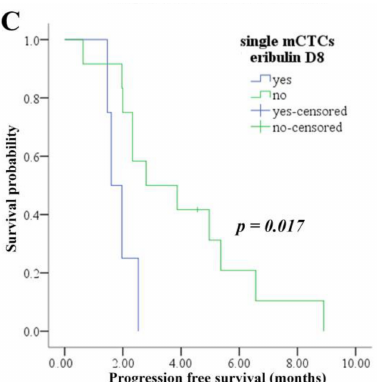
Figure 3. Detection and clinical significance of eCTCs / mCTCs subpopulations on D8 of the first eribulin cycle. ( A ) Percentages of eCTCs and mCTCs in total, single and cluster CTCs on days 1 (before eribulin) and 8 after the first administration of eribulin. Decrease in % of mCTCs in total CTCs ( p = 0.047) and in cluster CTCs ( p = 0.0001), are shown. Chi square test; statistical significance at the * p ≤ 0.05 and *** p ≤ 0.001. ( B , C ) Kaplan-Meier analysis of progression-free survival (PFS) according to the frequency of mCTCs ( ≥ 50% of total CTCs or not) ( B ) and the detection or not of single mCTCs ( C ). + Eribulin had no e ff ect in the number of PD-L1 CTCs, however it was shown to decrease the + mesenchymal PD-L1 population (Wilcoxon mean no: 2.82 vs. 1.59, p = 0.034), and especially the single + PD-L1 mCTC subset (Wilcoxon mean no: 1.76 vs. 0.59, p = 0.008) (Figure 4A,B). Specifically, in 9 out + of 12 patients (75%) reduced PD-L1 mCTCs were detected post-treatment (Figure 4A), while in 8 out + of 9 patients (89%) lower numbers of single PD-L1 mCTCs (Figure 4B).